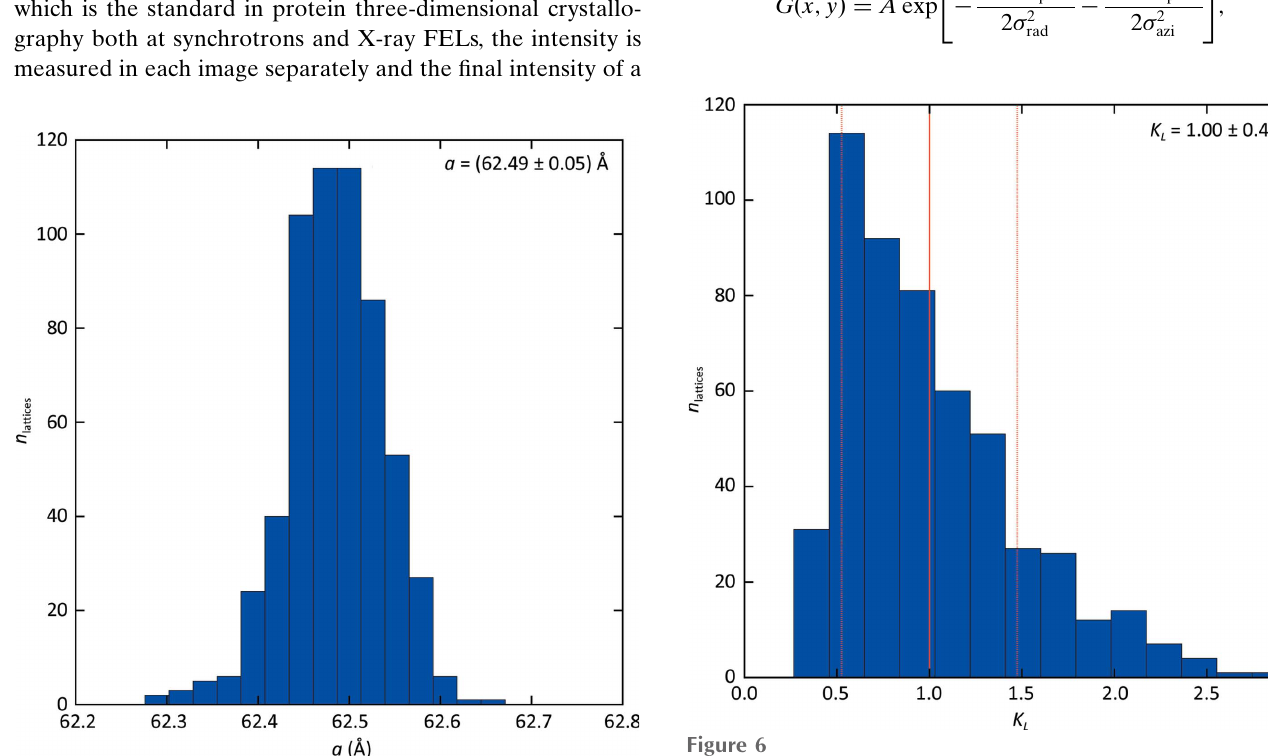
Figure 5 Unit-cell sizes. Histogram of the distribution of the lattice constant a refined for 586 lattices.